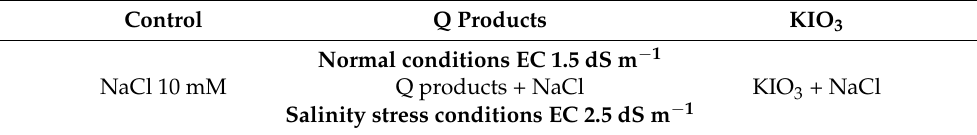
Table 2. Representation of treatments applied under normal and stress